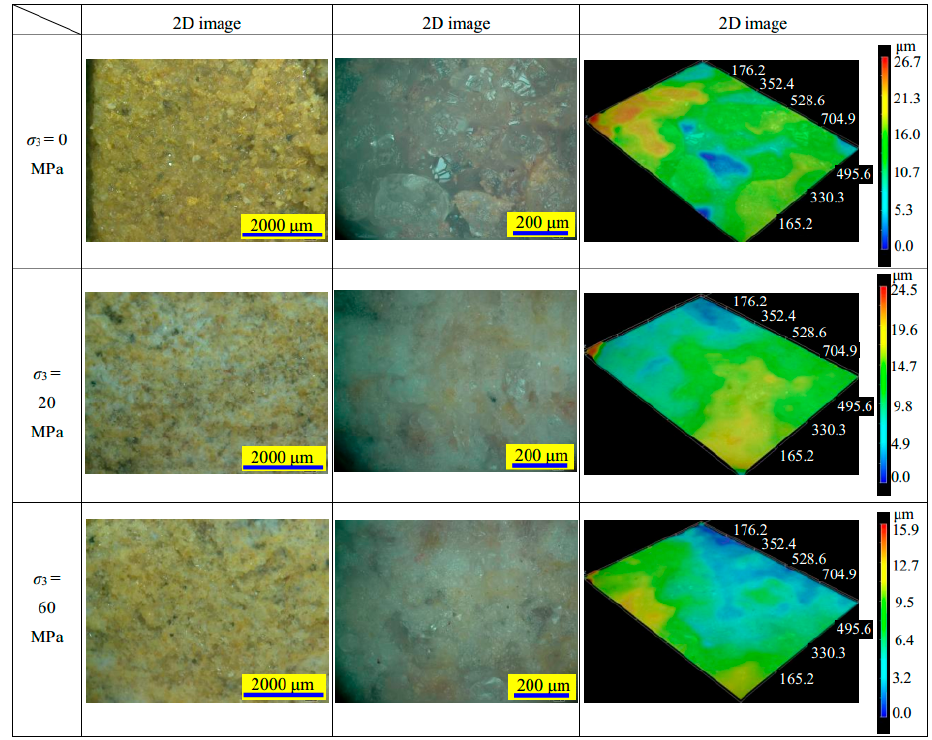
Figure 17. Micro-observation of the fracture plane of a sandstone specimen after failure under water saturation.